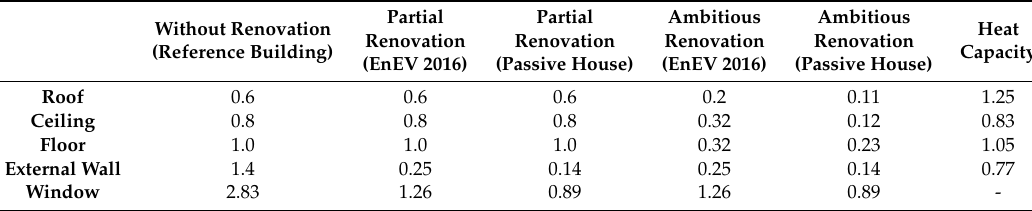
Table 3. U -values (W / m 2 · K) and heat capacities (kJ / kg · K) of the building envelope for di ff erent